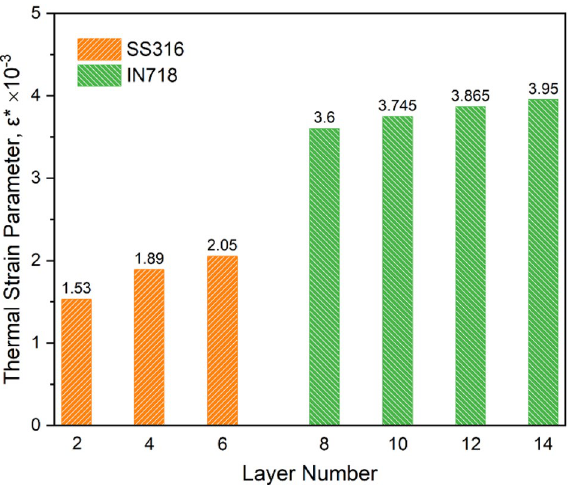
Figure 7. Thermal strain parameter ( ε ∗ ) variations in different layers of multi-material structure.